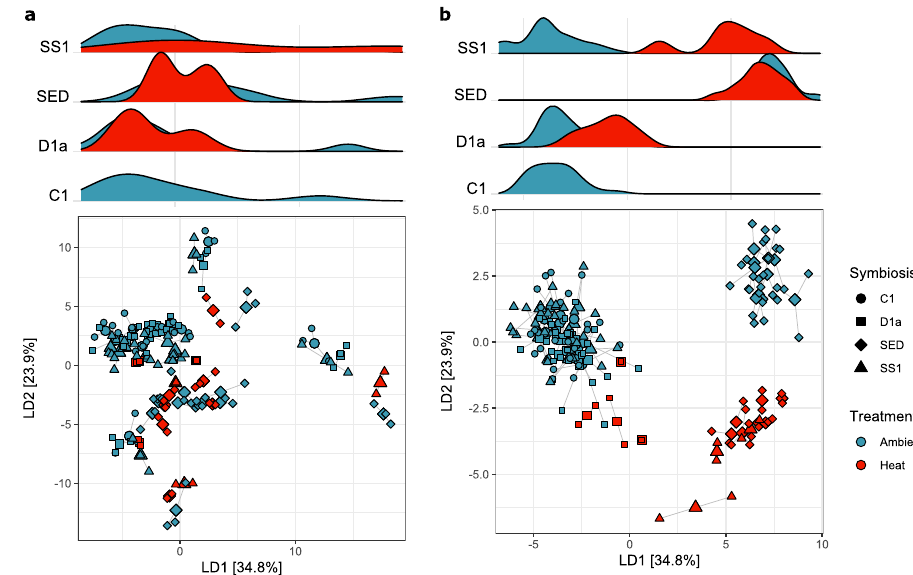
Fig. 3 | Juvenile gene expression responses to symbiosis and heat stress. Dis- criminantanalysisofprincipalcomponents(DAPC)ongeneexpressionofjuveniles hosting different symbioses under ambient and heat conditions. DAPC was